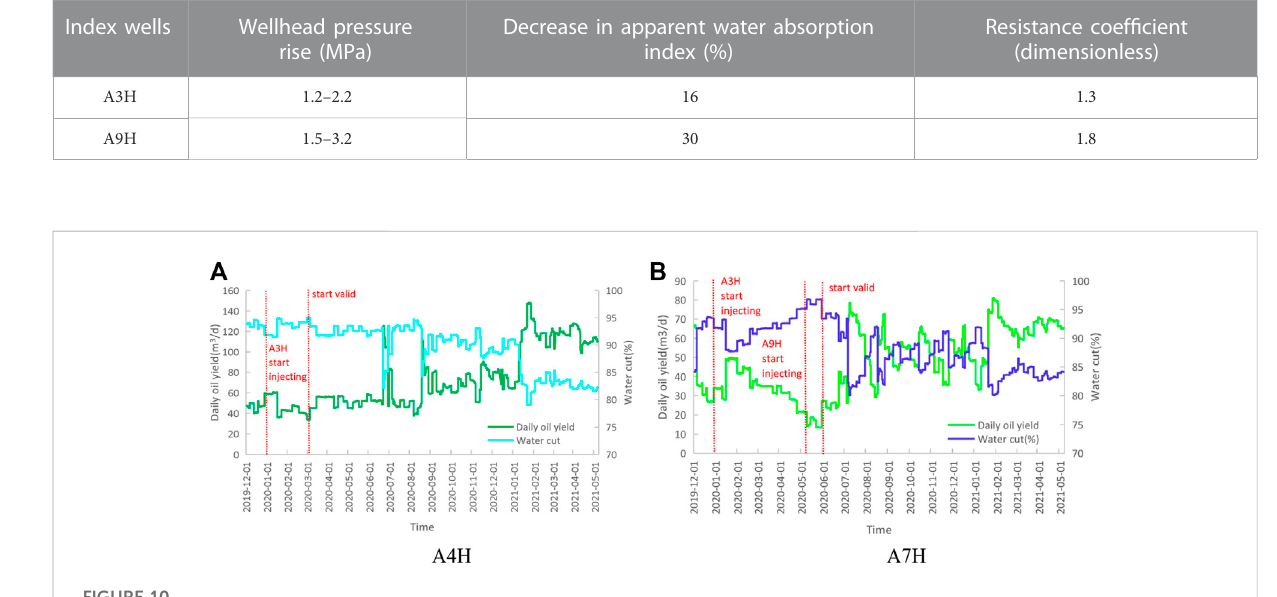
FIGURE 10 Production dynamic curve of production